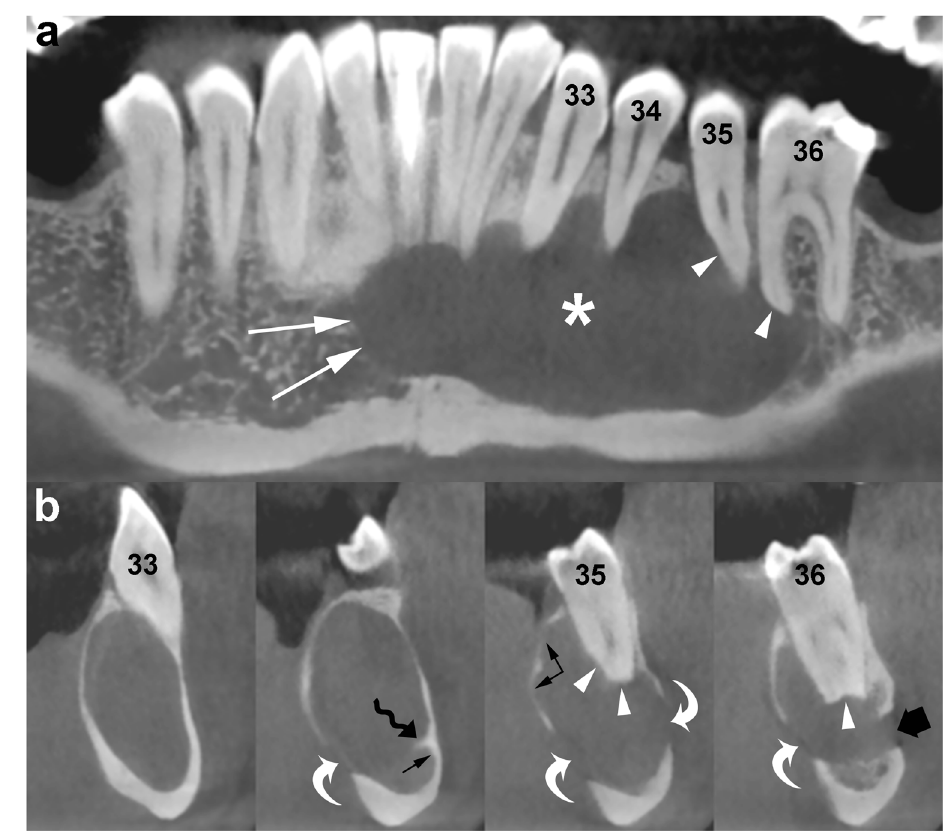
Fig. 8 Panoramic ( a ) and cross- sectional ( b ) CBCT images show an OKC with well-defined and lobulated margins located in the interforaminal region of the mandible ( asterisk ). The lesion grows mesially by crossing the midline ( white arrows ). Note root resorption ( arrowheads ) and perforation of the cortices ( curved arrows ). Scalloping of the endosteal surface of the cortical plates ( small black arrows ) and small internal septum ( wavy arrow ) are also seen. Large black arrow , left mental foramen; 33 , left canine; 34 , left first premolar; 35 , left second premolar; 36 , left